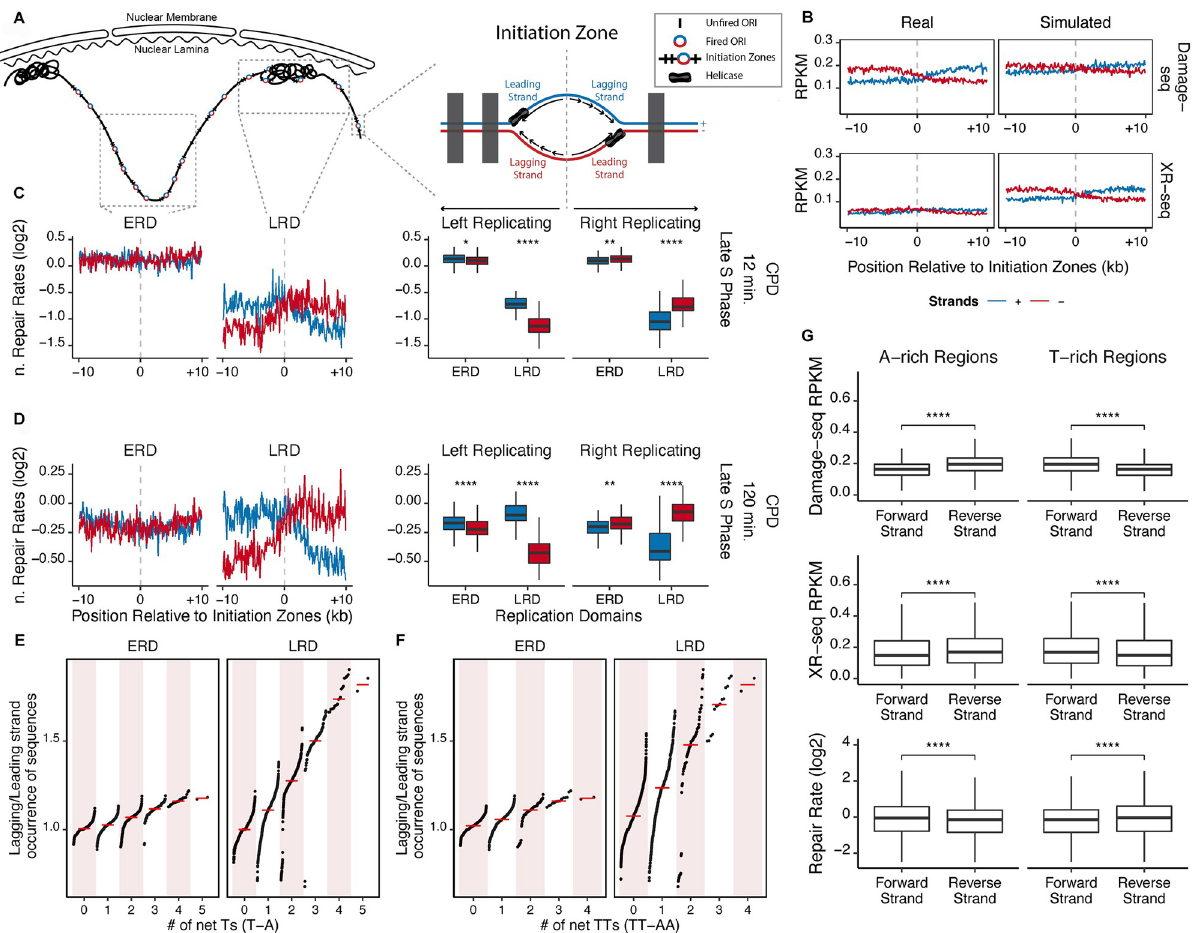
Fig 4. Repair rate and sequence context asymmetry around initiation zones in ERDs and LRDs. (A) Schematics of replication domains (Left), and initiation zones (Right). (B) Damage and repair profiles of real and simulated reads around initiation zones in LRDs for CPDs at 0 minutes (for damage), 12 minutes (for repair). (C-D) (Left) CPD normalized repair rates [log2 (XR seq real/simulation /Damage-seq real/simulation )] at 12 minutes (C), and 2 hours (D) in late S phase around initiation zones that were separated into corresponding replication domains. (Right) The boxplot of windows in left replicating and right replicating directions are shown separately for plus and minus strands. Paired wilcoxon test was used to assess the significance of differences between the strands. Number of initiation zones in ERDs: 2130; in LRDs: 1450. (E-F) Correlation of relative occurrence of all mono- to penta-nucleotide sequences on the lagging and leading strand and the number of net Ts (T-A) (E) and net TTs (TT-AA) (F) for each sequence. Each dot represents a sequence (separate dots for left and right replicating directions), and the red bar represents the median of the Lagging/Leading strand values for each net T value. Replicate A and B are combined. (G) Strand differences of damage, repair, and repair rate in A-rich and T-rich regions. Boxplot of Damage-seq (top), XR-seq RPKM values (middle), and log2 transformed repair rates (bottom) of asynchronized CPDs at 12 minutes in A- rich and T-rich (see